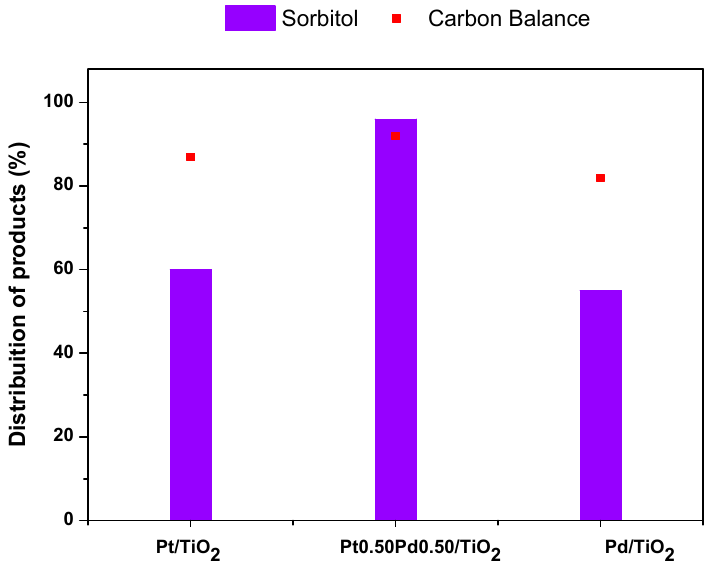
Figure 5. Glucose hydrogenation to sorbitol using Pd, Pt, and PtPd catalysts supported on TiO 2 . Distribution of products at glucose iso-conversion of 80%. Conditions: 2 mL of aqueous solution of glucose, 10 mg of catalyst, 2 h, glucose:metal (mol) = 600.